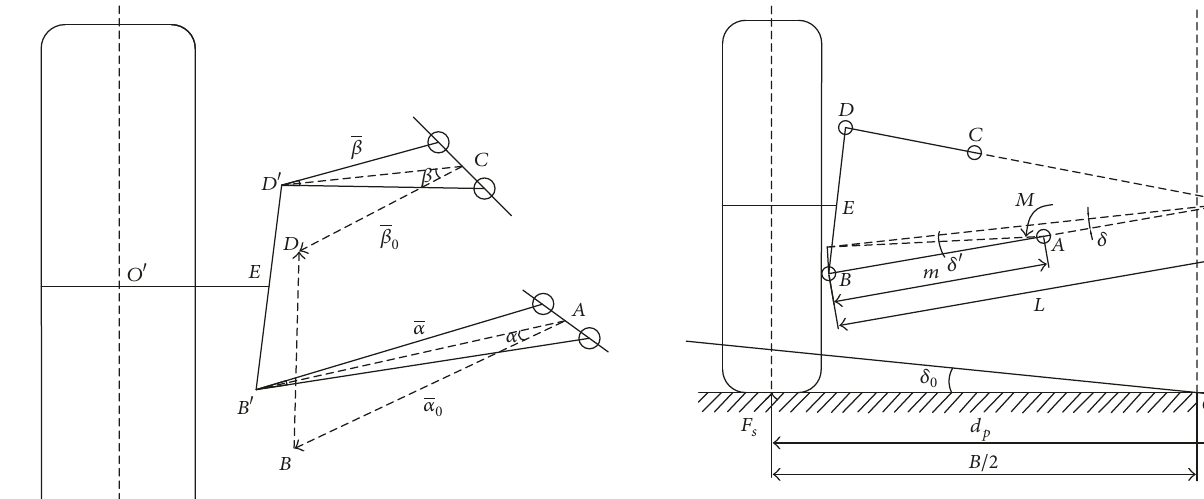
Figure 3: Force model of the